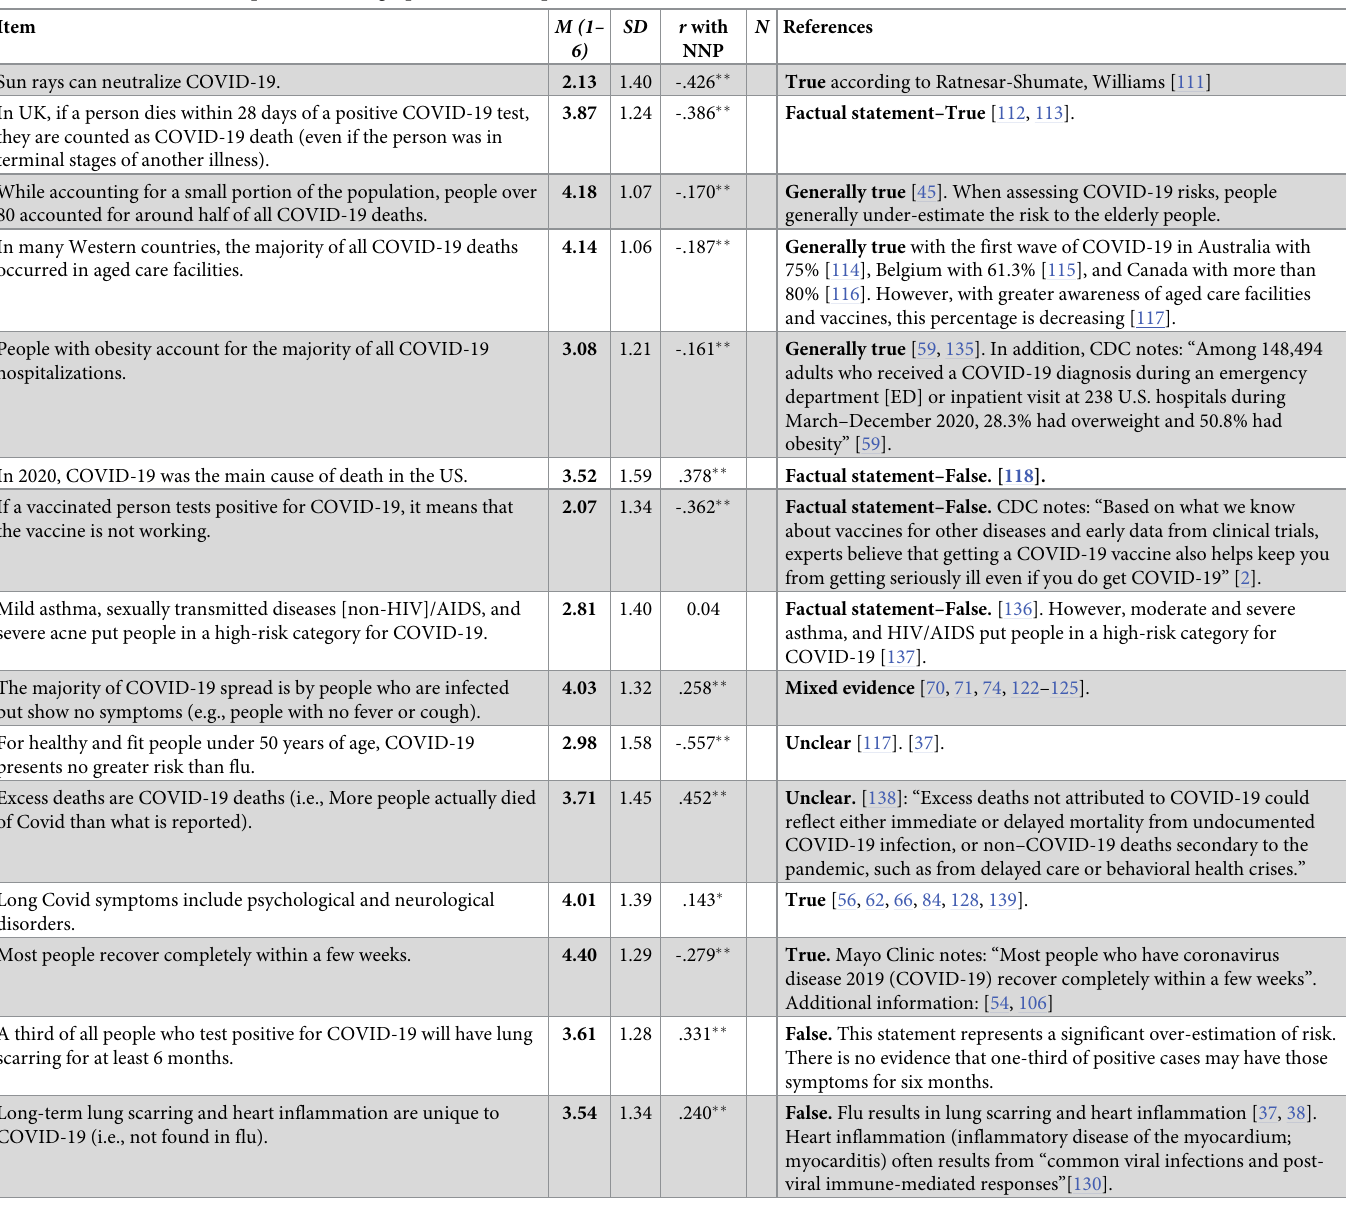
Table 15. NNP and relationship with knowledge questions in Samples C and